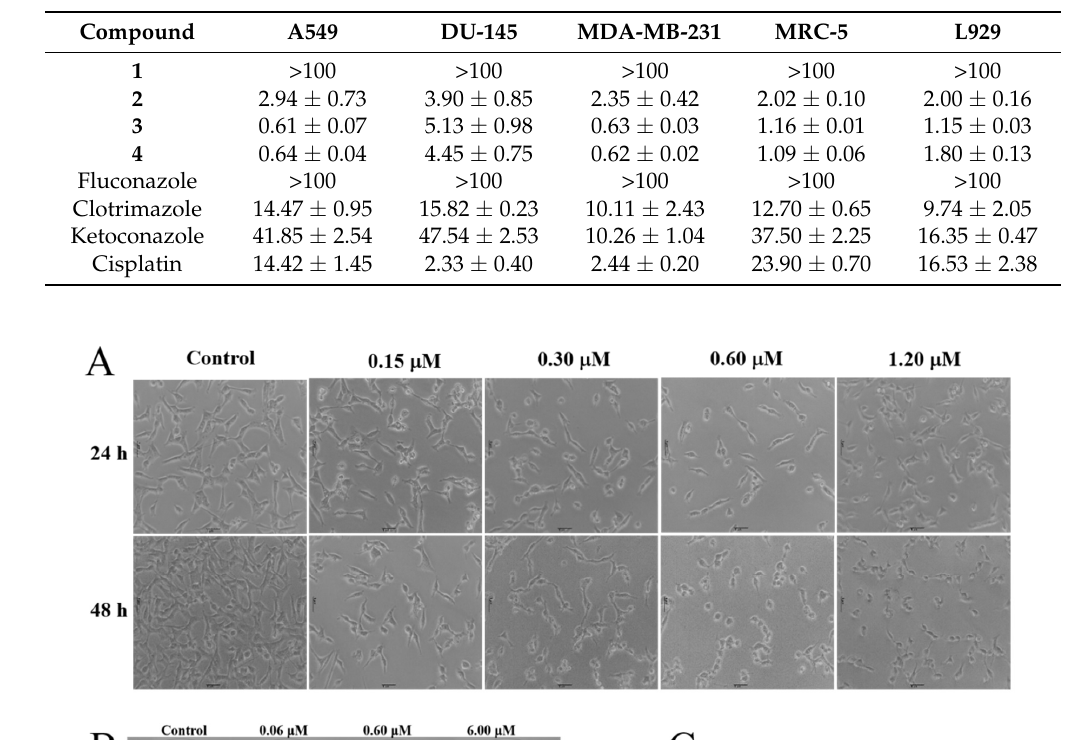
Table 3. In vitro cytotoxicity in micromolar concentrations of the complexes in tumor cells A549, DU-145, MDA-MB-231 and non-tumor cell MRC-5, L929 by 48 h.